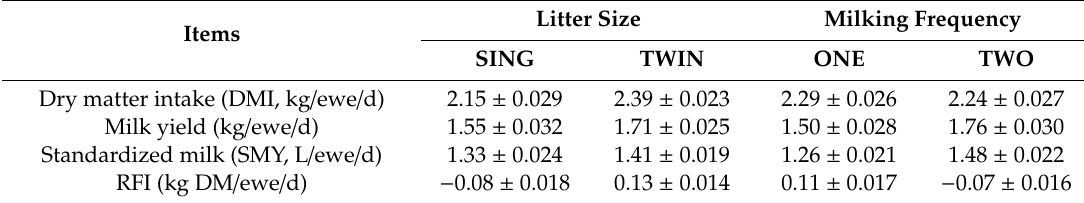
Table 3. E ff ects of litter size and milking frequency on dry matter intake (DMI, kg / ewe / d), actual or standardized (SMY) milk yields (L / ewe / d), and residual feed intake (RFI, kg / ewe / d) of individually fed primiparous Lacaune dairy ewes at mid-lactation (42–98